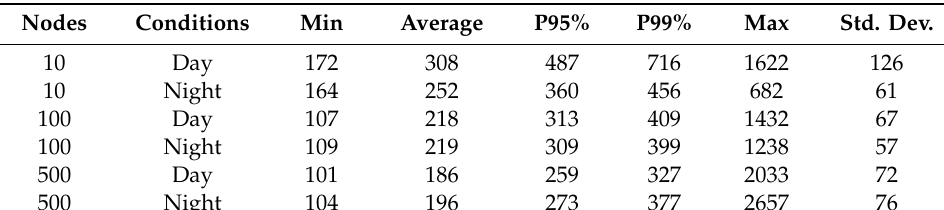
Table 8. Statistics of the L CDC (latency introduced by the database) collected in the scalability experiments. All values are in milliseconds.